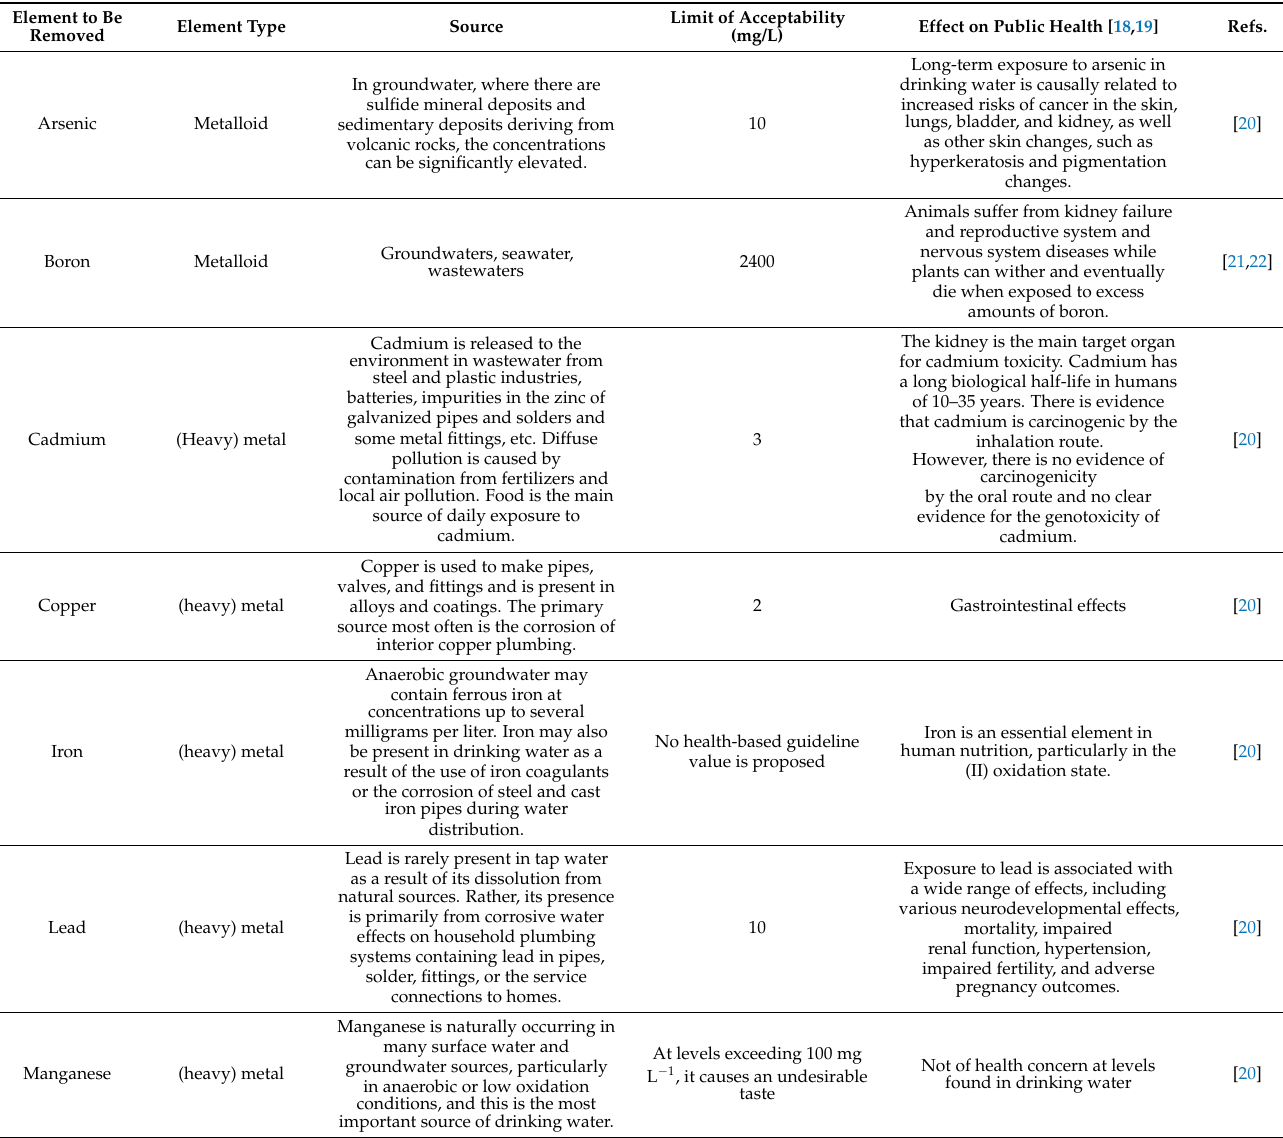
Table 1. Heavy metals and metalloids in drinking